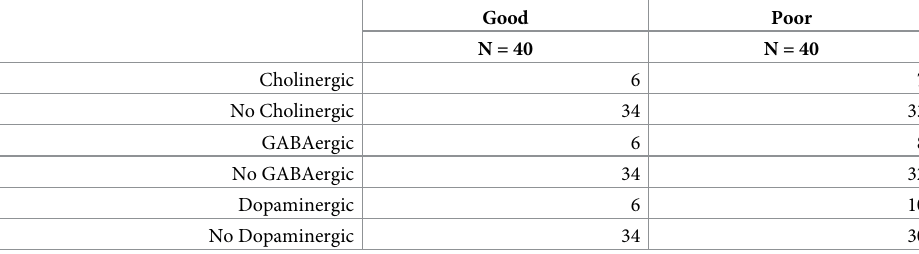
Table 4. Patient grouping by recovery group and drug